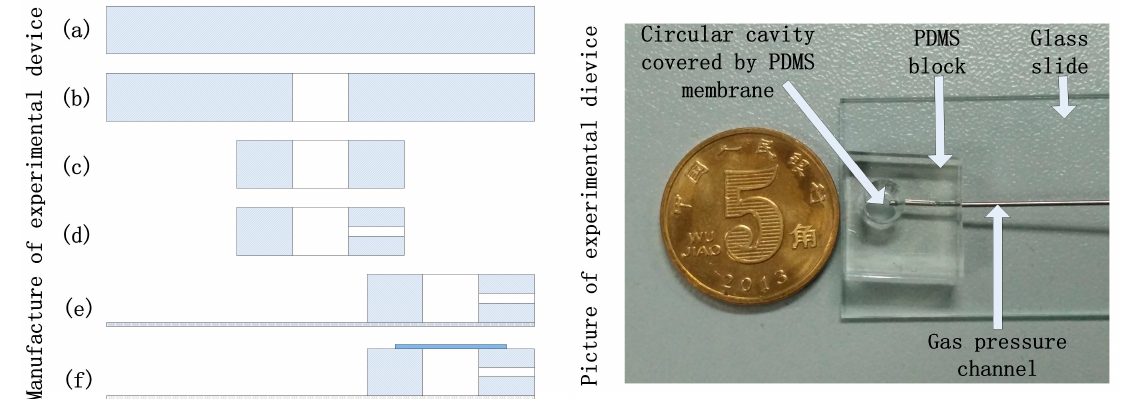
5 of 13 membrane capacitance. The proposed process can be used for on-chip measurement of hydraulic capacitance of the real microfluidic components before final package. 3. Materials and Methods 3.1. Experimental Setup RTV615 PDMS elastomer pre-polymer and curing agent were purchased from Momentive (Waterford, New York, NY, USA). The pressure source was a nitrogen bottle, which was regulated by a pneumatic pressure controller (MFCS, Fluigent, Paris, France) to produce high precision pressure to apply on the surfaces of the round PDMS membrane. This pneumatic pressure controller allowed almost non-fluctuating flow, which was essential to maintain the stability of the deformed membrane. The uniform gas pressures exerted on the membrane were from 0 to 25 mbar and the pressure step was 0.5 mbar. A high-speed camera (ORCA-flash, Hamamatsu, Shizuoka, Japan) mounted on an inverted optical microscope (Eclipse TE 2000-U, Nikon, Tokyo, Japan) was used to get the image of the deformed membrane. The custom made PDMS membrane testing chamber in this paper was fabricated as follows, as shown in Figure 3. A small PDMS block was fabricated by pouring the mixture of PDMS pre-polymer and curing agent (10:1 w / w ) into a petri dish, keeping the thickness about 5 mm, putting the petri dish on a horizontal table at room temperature, and baking the PDMS properly to increase its hardness to form a PDMS pie after solidification with parallel surfaces (Figure 3a). Holes with different diameters were punched on the PDMS pie (Figure 3b), the PDMS pie was cut into small blocks containing round holes (Figure 3c). A side channel in the small PDMS block was punched to communicate with the round hole, which can be used as the uniform pressure channel (Figure 3d). The small PDMS block and the microscope slide was bonded together through oxygen plasma (Figure 3e). The PDMS membrane was fabricated through spin-coating that the mixture of PDMS pre-polymer and curing agent was poured onto a polished silicon wafer; different mixing ratio of the pre-polymer and curing agent, and the rotational speed and time for spinning were adjusted to fabricate the PDMS membranes with different thickness and mechanic properties. The PDMS membrane covering wafer was then baked in an oven at 80 °C for 40 min, and finally the PDMS membrane was cut into the right size, tiled on a PMMA block without tension (was not shown in Figure 3), and bonded to the small PDMS block by oxygen plasma (Figure 3f). The PMMA block acted as the carrier of the PDMS membrane, which can reduce the preload tension of the PDMS membrane and keep the PDMS